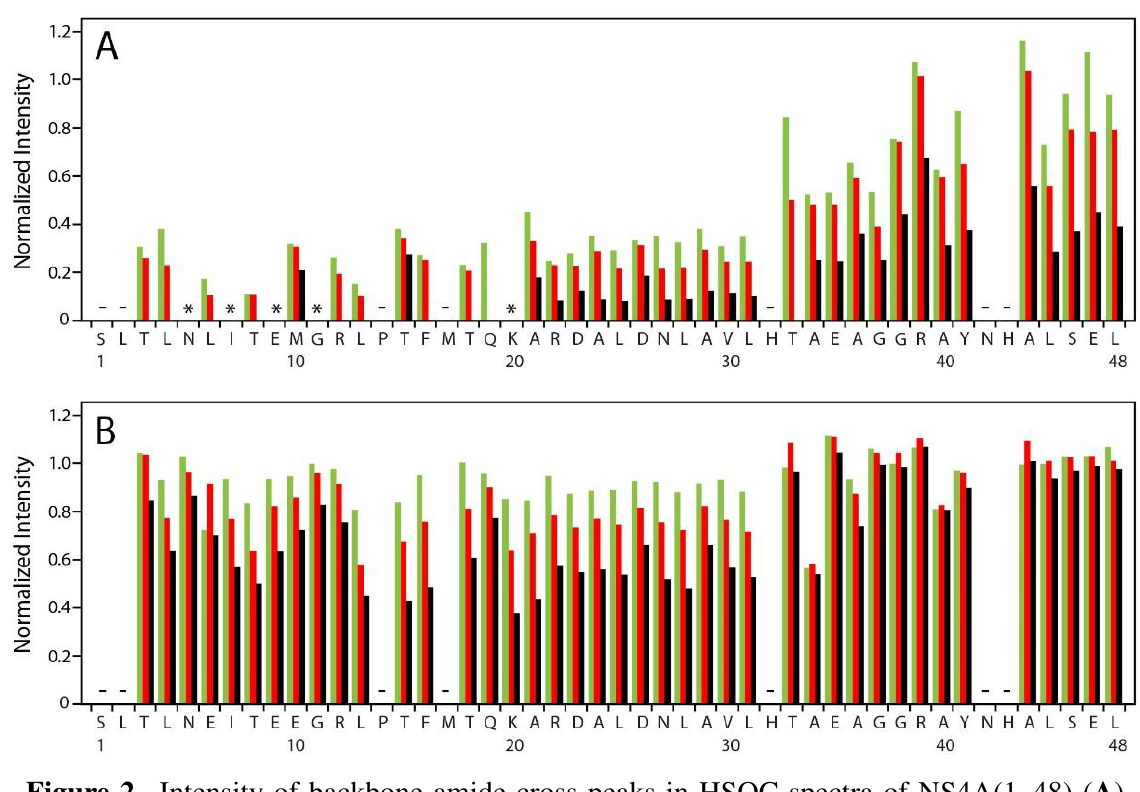
Figure 2. Intensity of backbone amide cross peaks in HSQC spectra of NS4A(1–48) ( A ) and NS4A(1–48, L6E;M10E) ( B ) recorded at various lipid concentrations. Peak intensities measured at 2.5 (green), 5 (red) and 10 mg·mL −1 POPC (black) in the sample were normalized to the intensity of the same signal observed in lipid-free buffer and are shown as a function of the amino acid sequence of the studied peptide. Cross peaks not observed in the lipid-free sample are indicated by minus signs. Cross peaks that are present in buffer but completely disappear after addition of 2.5 mg·mL −1 POPC are indicated by asterisk.